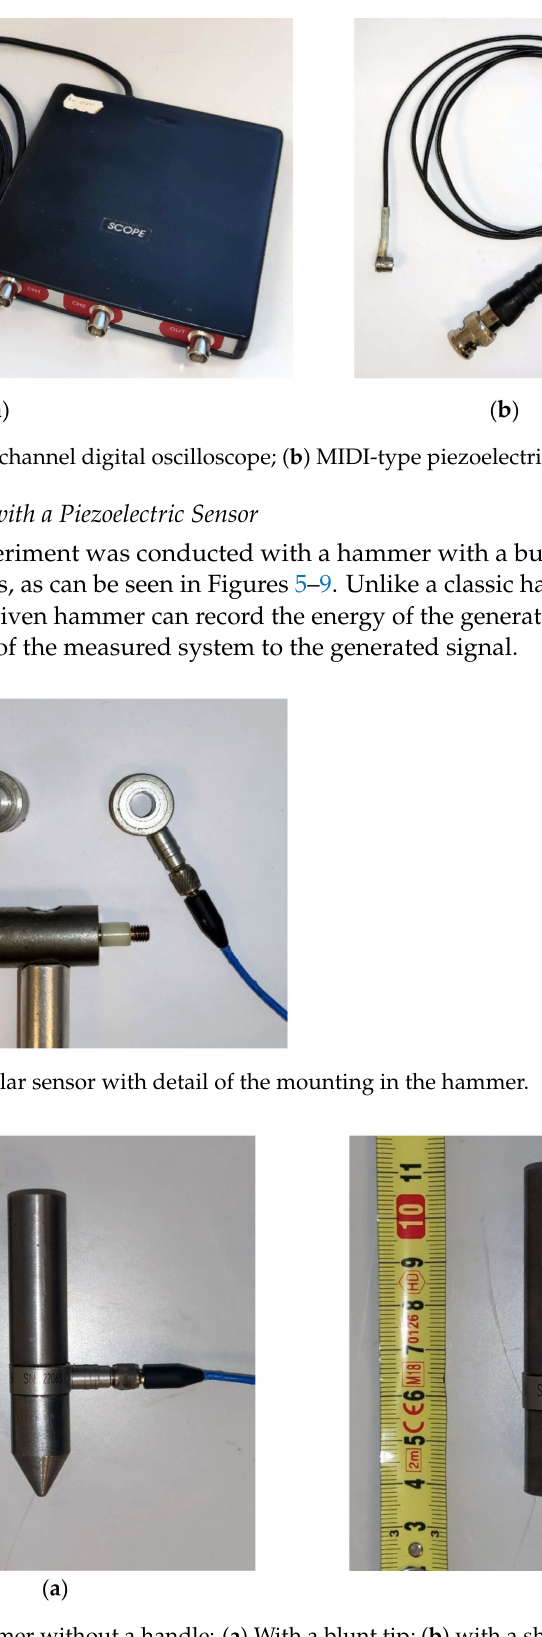
Figure 7. Hammer without a handle: ( a ) With a blunt tip; ( b ) with a sharp